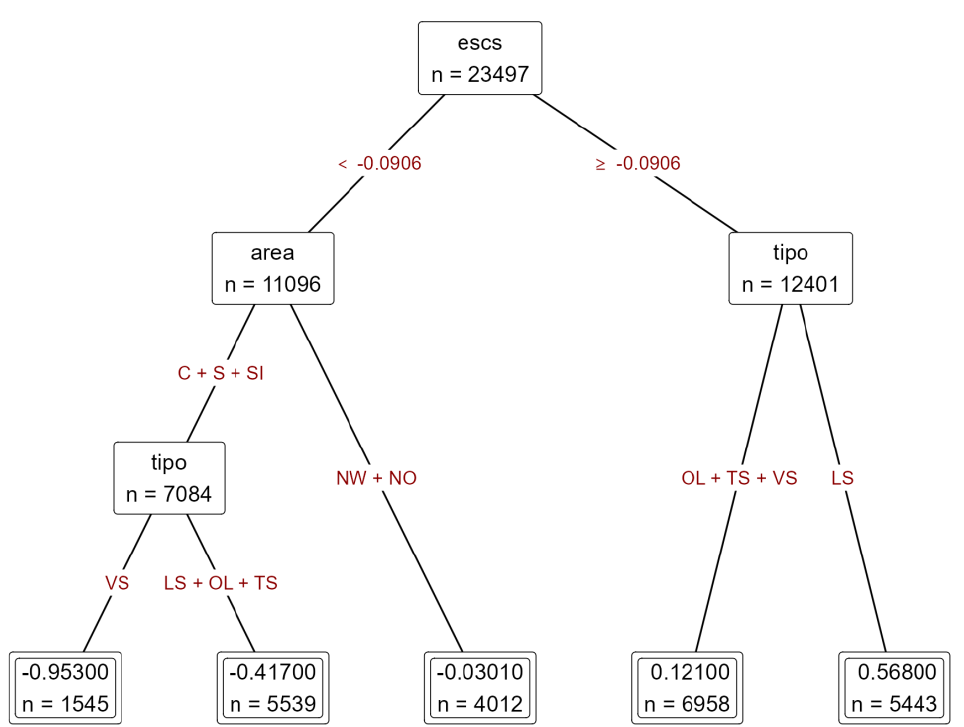
Figure 6. The decision tree. Note: escs = ESCS; area = geographic macroregion; tipo = school typology; OL = other lyceums; SL = scientific lyceums; TS = technical schools; VS = vocational schools; NE = Northeastern Italy; NW = Northwestern Italy; C = Central Italy; S = Southern Italy; SI = Southern Italy and Isles.